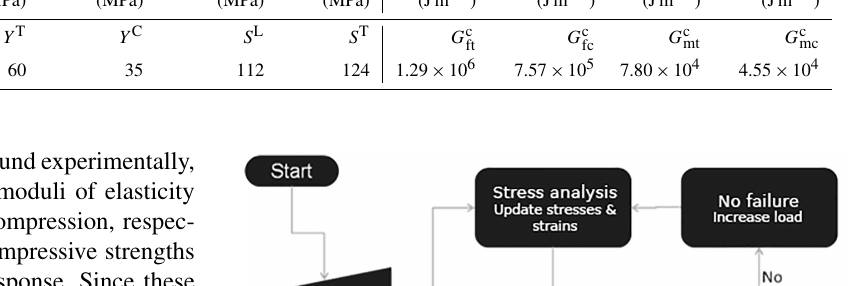
Table 2. Damage initiation and evolution parameters utilized in progressive damage analysis. Damage initiation (strength) parameters Damage evolution (energy dissipation) parameters Property Longitudinal Longitudinal Transverse Transverse Longitudinal Transverse compressive tensile compressive